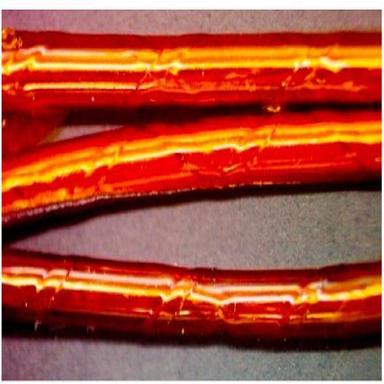
Baseline (top), atmospheric (middle), and vacuum (bottom) polyimide insulations.